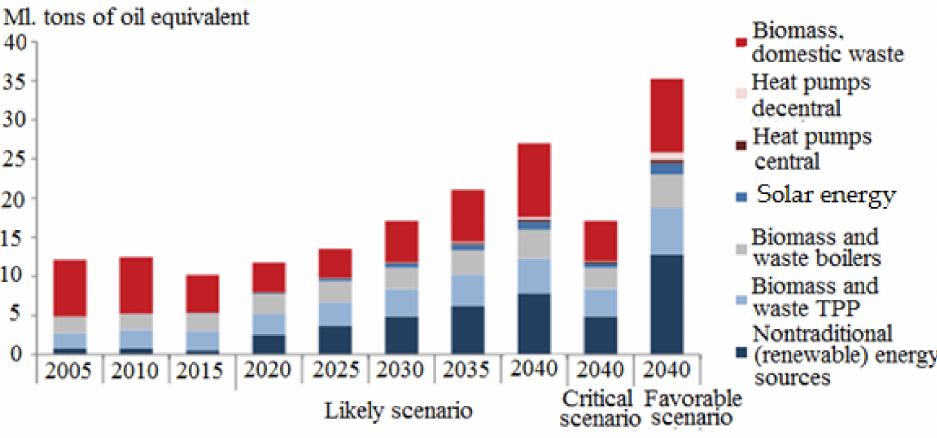
Figure 1. Russia (cid:48) s estimated use of nonconventional renewable energy resources, 2005–2040 [1,2]. Until the mid-1970s, the development of the world fuel and energy complex was reliant upon traditional carbon fuels. The fuel crisis in the end of 1970s led to a significant increase in the cost of oil and new energy policy [1,2]. The following decades were characterized by the growth of electricity consumption from nontraditional sources. For 10 years from 2006 to 2015, wind power use increased by almost 6 times and solar energy increased by 37 times (Figure 2).